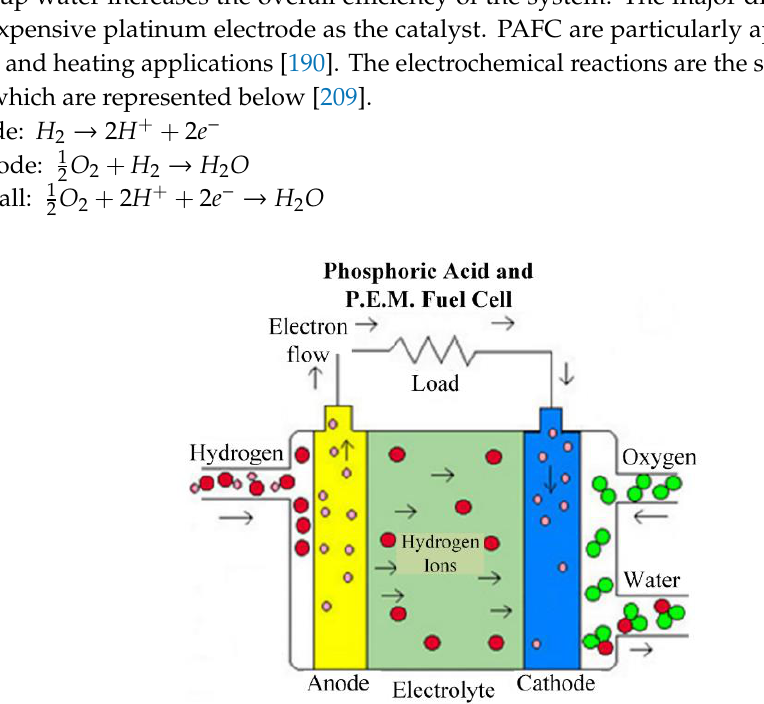
Figure 66. Schematic diagram of the phosphoric fuel cell (PAFC); phosphoric acid is used as the electrolyte in this system [209].